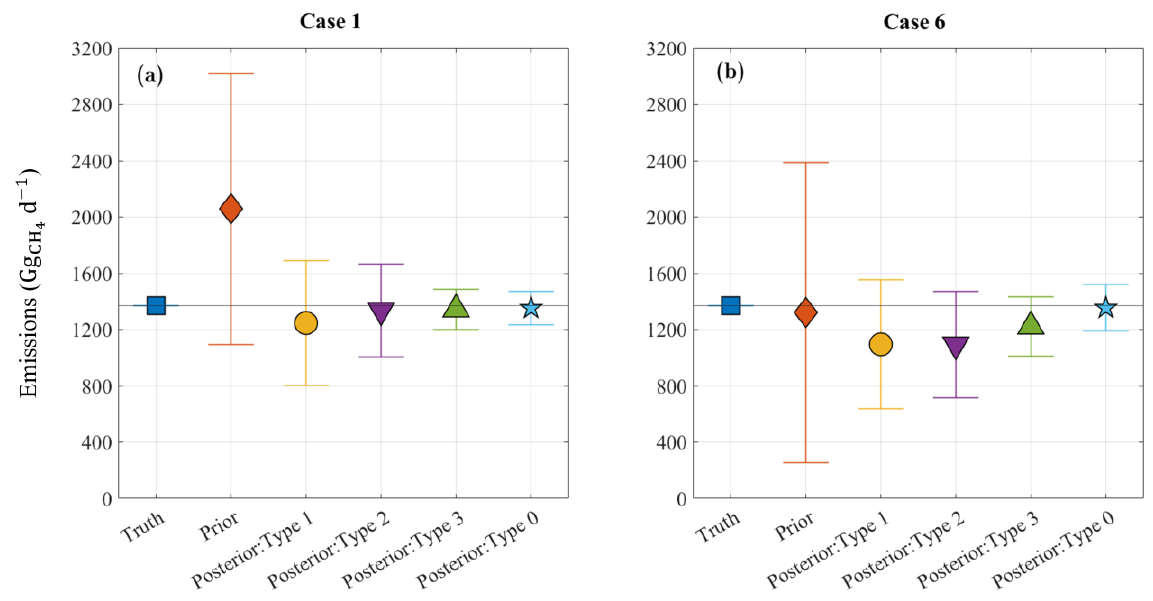
Figure 7. ( a ) Total emissions of the truth, prior, and four types of posteriors (Type 0–3) associated with Case 1 inversion with uniform perturbation of total emissions; ( b ) total emissions of the truth, prior, and four types of posteriors (Type 0–3) associated with Case 6 inversion with non-uniform perturbation of total emissions.